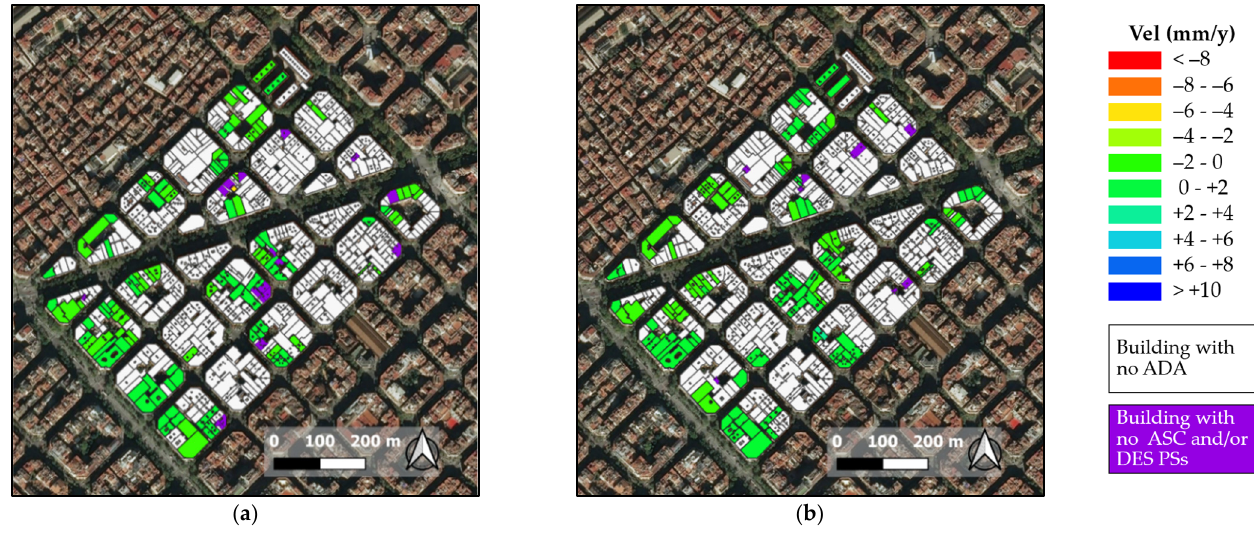
Figure 6. Maps of buildings in Eixample area with an average value of mean deformation velocity along ( a ) ascending and ( b ) descending orbit. The violet polygons represent buildings with lack of PSs.